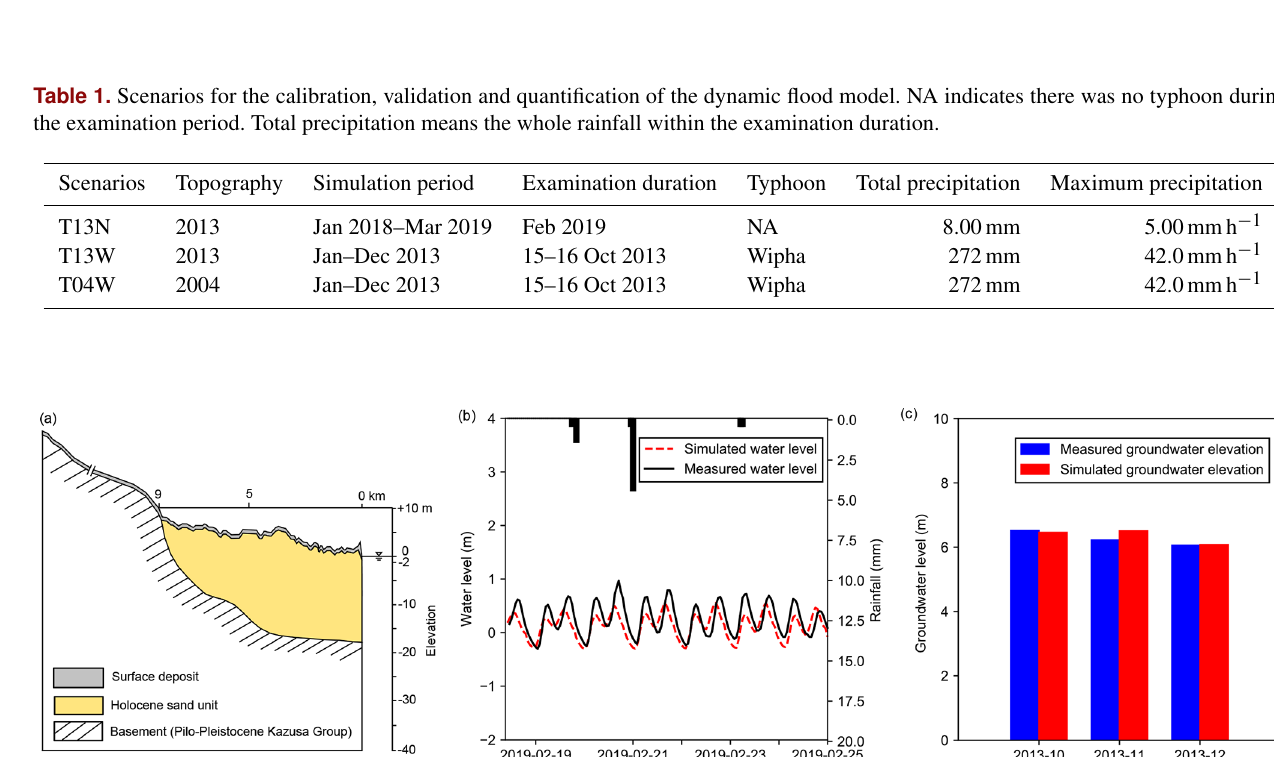
Figure 1. Location and topographic map of the study area. (a) The location of the study area. (b) The topographic map of research site in the year 2013. Torabashi is a river gauging station, where the river water level was used to calibrate the model parameters. Kujukuri_1 is a groundwater observation well, where the validation of the model was performed. The modelled geological cross section along the line A–A (cid:48) is shown in Fig. 2a.